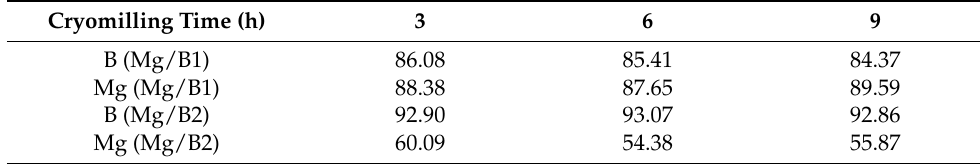
Figure 6. XPS spectrum of ( a ) B1s, ( b ) Mg2p of Mg/B1, ( c ) B1s, and ( d ) Mg2p of Mg/B2cryomilled for 9 h. Table 3. The activity content (%) of Mg and B in Mg/B composite